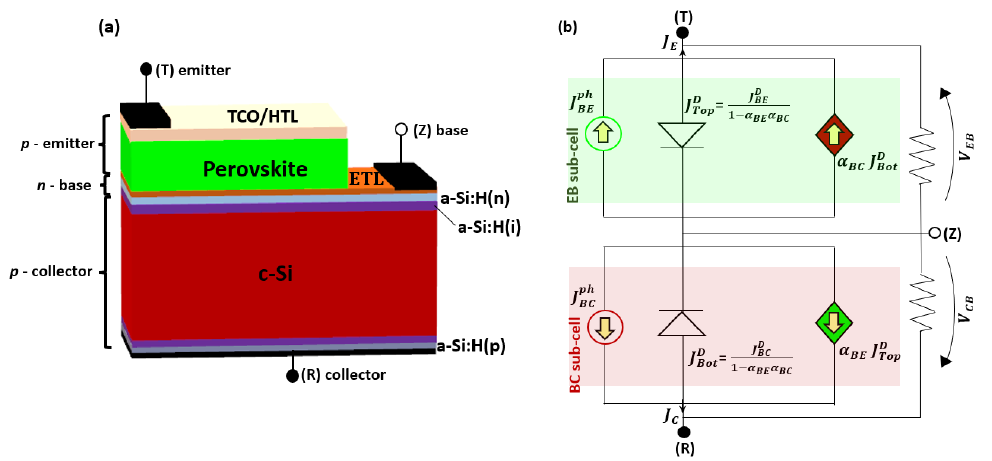
Figure 2. ( a ) Three-dimensional (3D) schematic view of a 3T-HBT PVK/HIT-silicon tandem with top interdigitated contact scheme. The three contacts for emitter, base, and collector are named as T, Z, and R, respectively. ( b ) Equivalent electrical circuit of the p-n-p 3T-HBT solar cell sketched on the left under